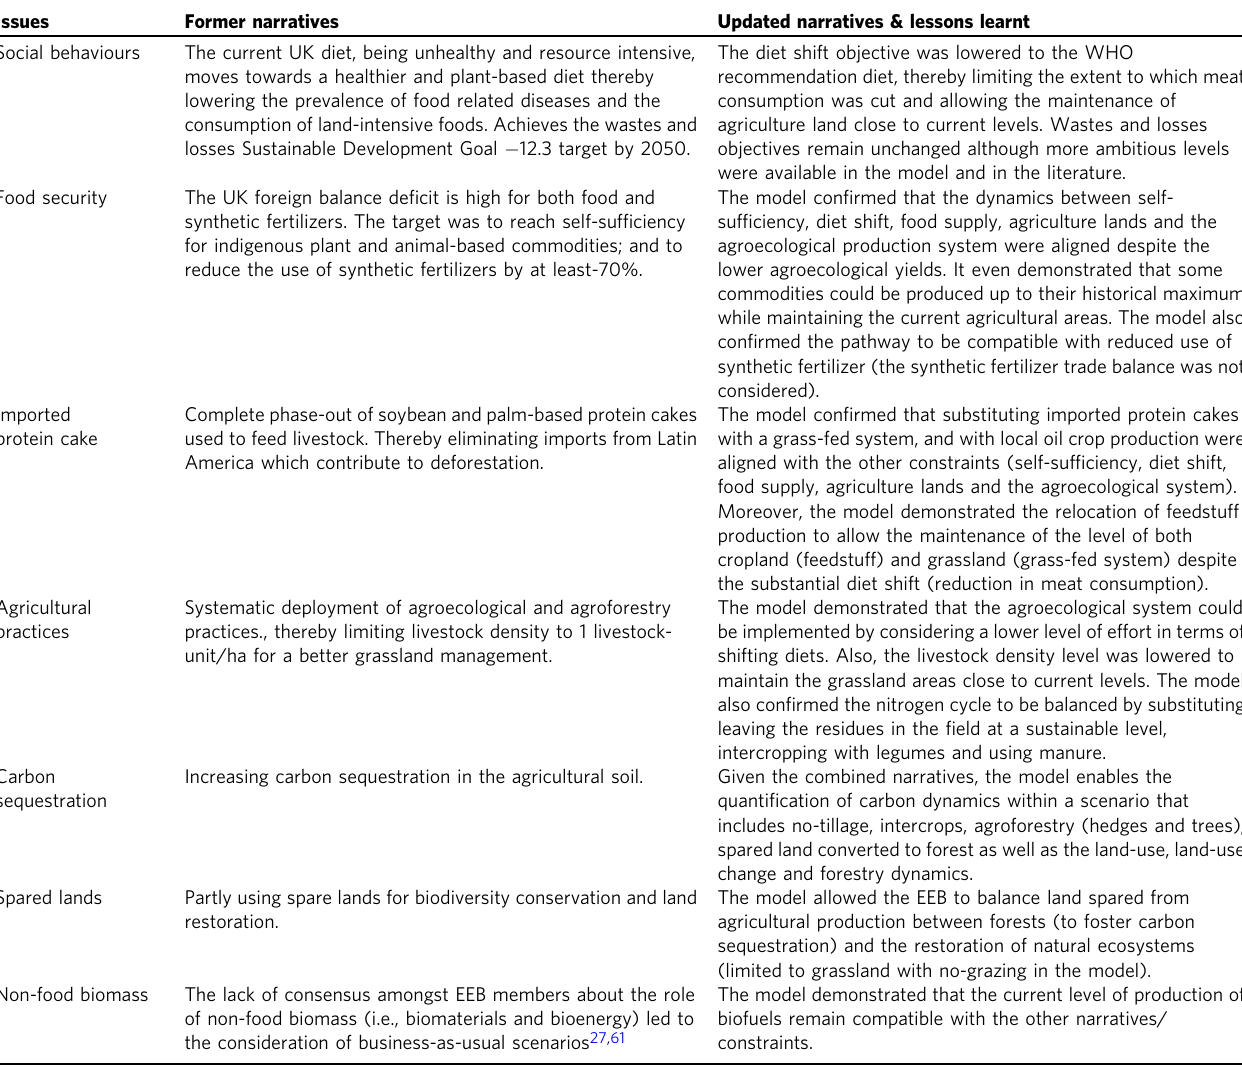
Table 1 EEB main narratives in a brief.